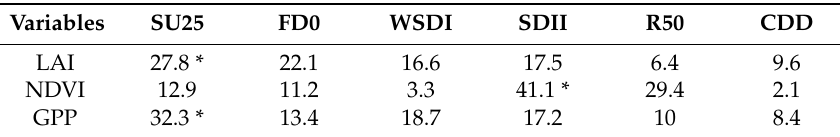
Table 5. Relative contribution rates (%) of the six climate indices to ecosystem variables in Hubei Province.